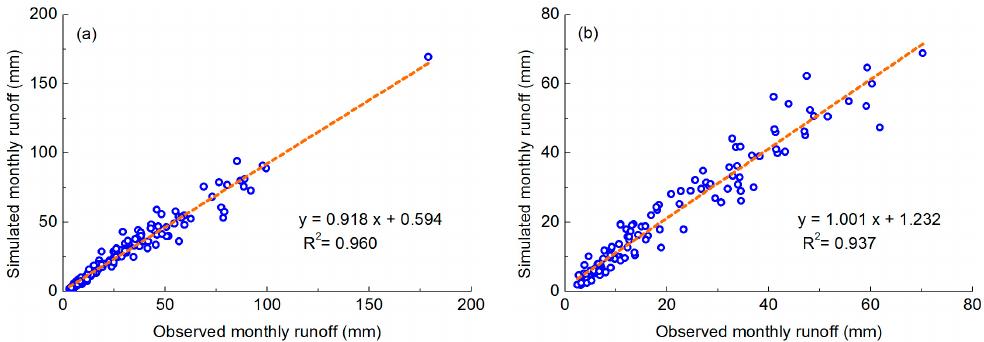
Figure 5. Comparison of the observed and simulated daily runoffs during the calibration and validation periods for the URRB.